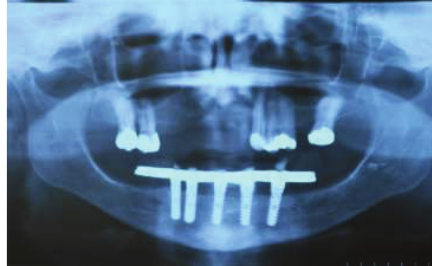
Figure 8: Panoramic radiograph after 12